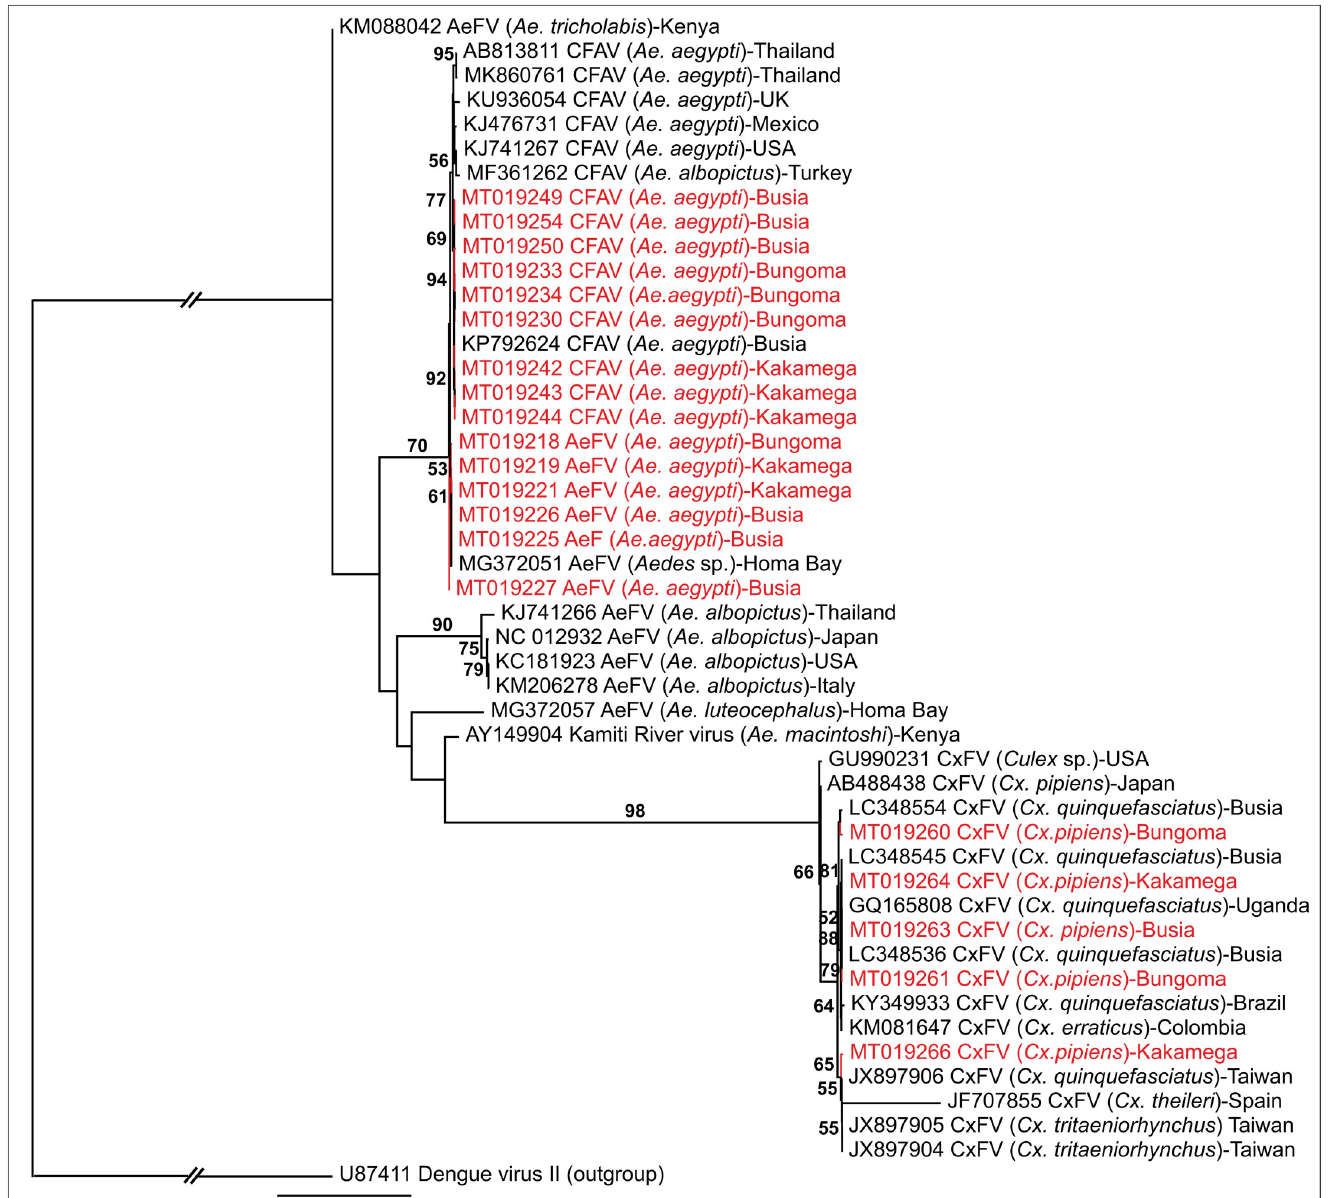
Fig 5. Maximum likelihood phylogeny of flaviviruses inferred from 48 aligned 900-nt segments of the NS5 gene. Taxon names include GenBank accession numbers, isolation source, and country of origin. Sequences from this study are in red. Bootstrap values at the nodes are of percentage agreement among 1,000 replicates. The branch length scale represents substitutions per site. The gaps to the outgroup represents 2.1 substitutions per site.